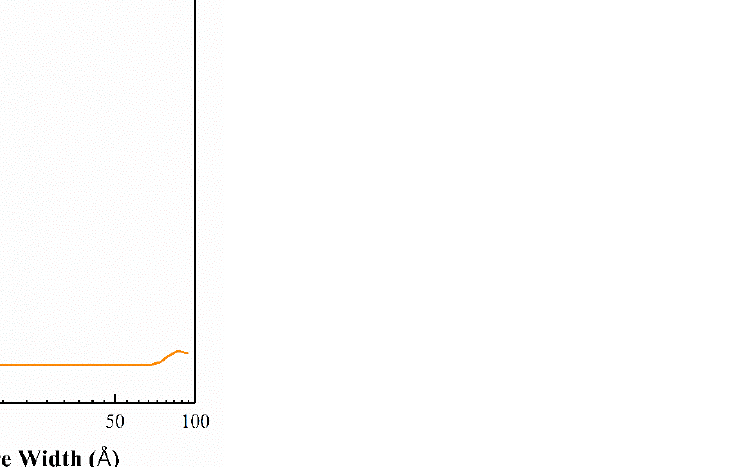
Figure 10. Pore size distribution of the 20-ZnO@ZIF-8 gas sensor.